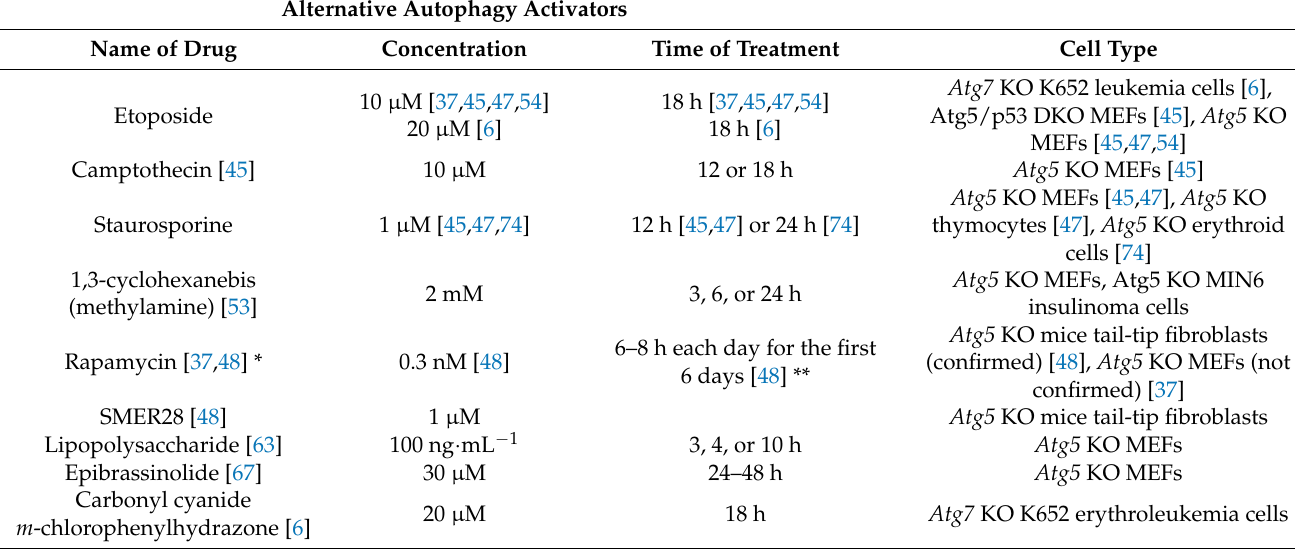
Table 1. Alternative autophagy activators.